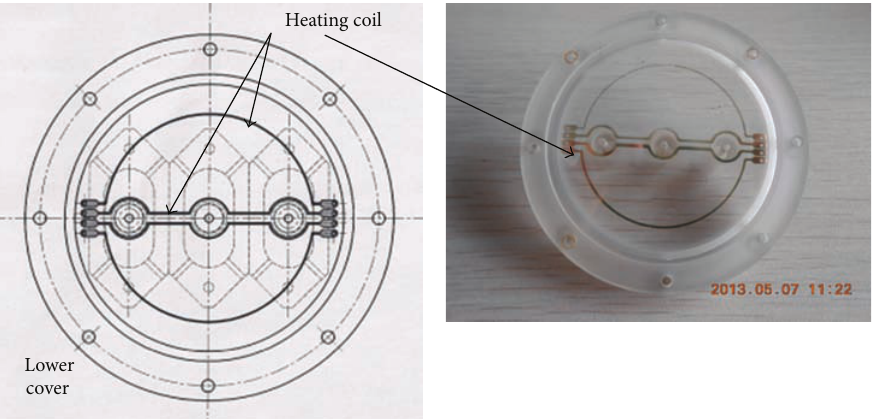
Figure 6: The engineering drawing for lower cover of cell culture